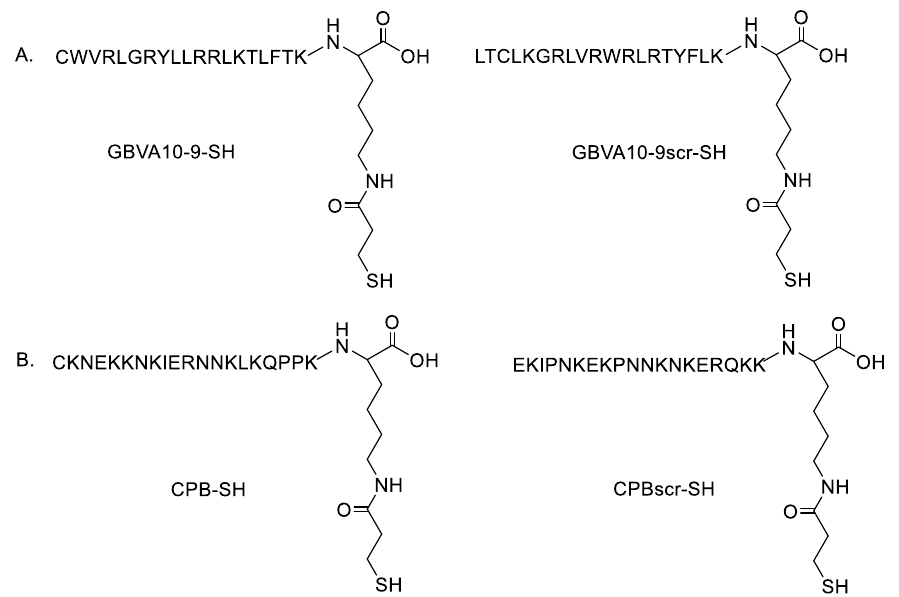
Figure 1. Structure of: ( A ) GBVA10-9 and its scrambled control (GBVA10-9scr), and ( B ) CPB and its scrambled control (CPBscr).